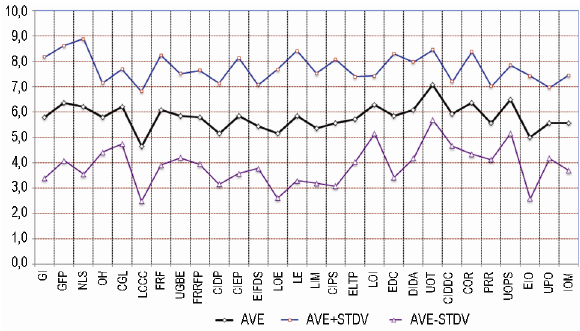
Fig. 3. Average EM composite attribute weights with its boundaries of ± standard